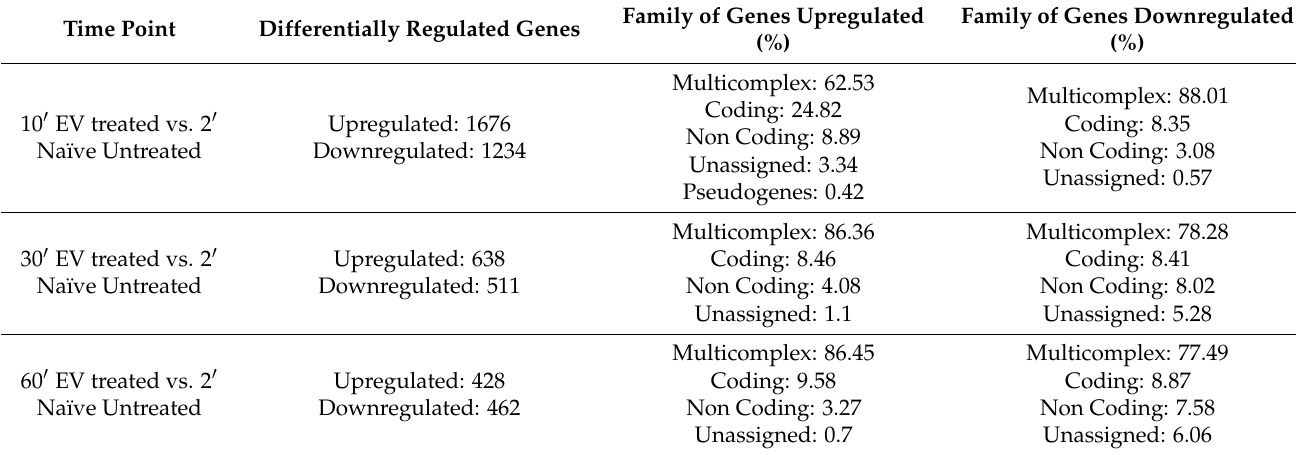
Table 2. Table of phosphorylated proteins identified by mass spectrometry in the EVs isolated from CTCs with active site identified and biological significance of the site in protein signaling